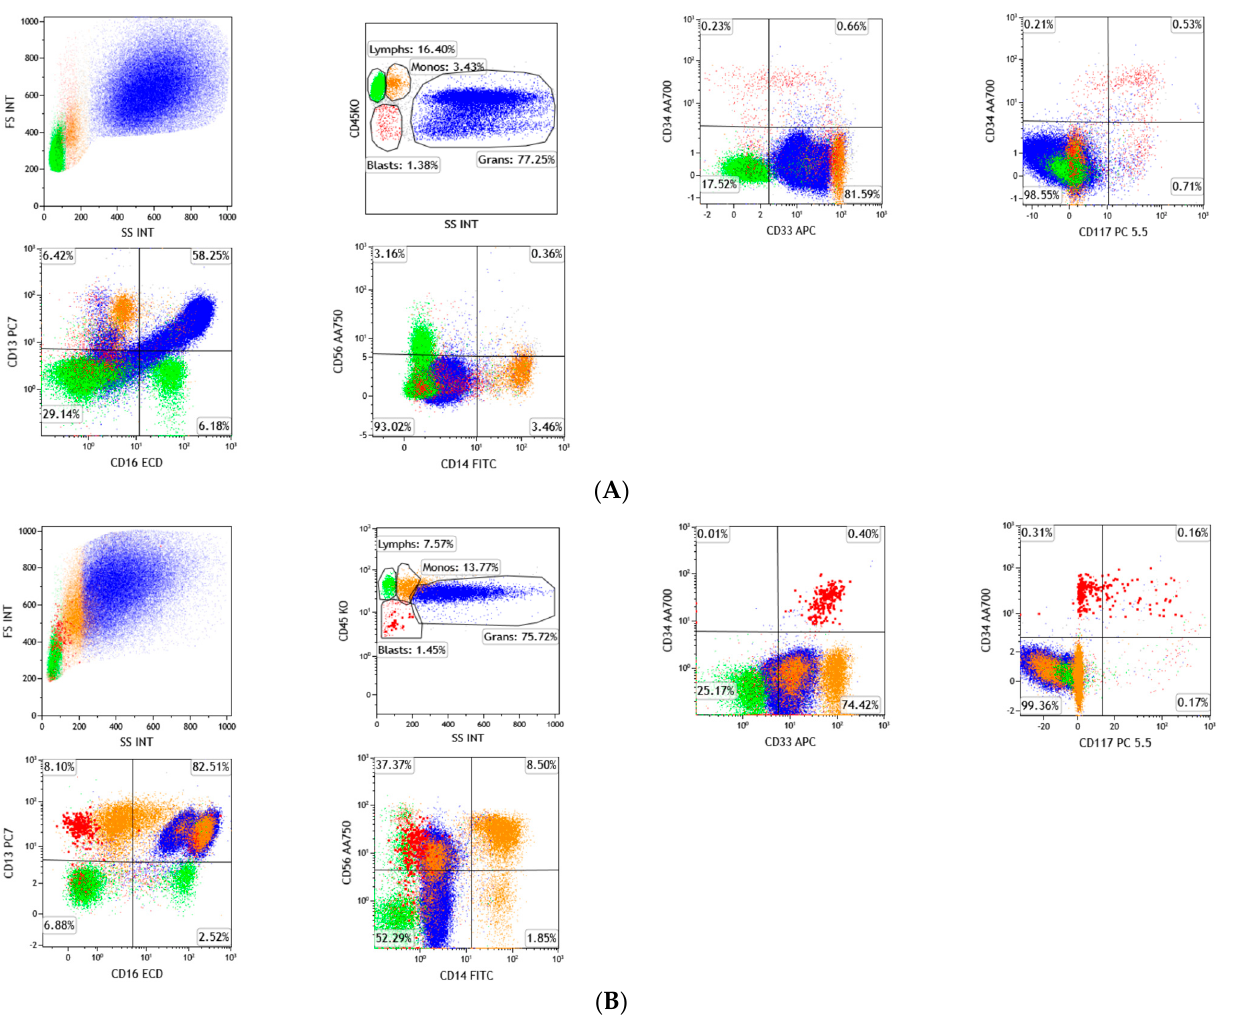
Figure 2. ( A ) Shows normal maturational pattern of nucleated hematopoietic cellular populations. Regenerating myeloblasts showing intact CD34 and CD117 expression and heterogeneous CD33 positivity. Maturing granulocytic precursors showing the classic “Nike swoosh” pattern in the CD13/CD16 plot, and monocytes showing intact expression of CD14, without aberrant antigen expression. Lymphocytes in green, monocytes in orange, granulocytes in blue, blasts in red ; ( B ) Case of MDS showing myeloblasts with loss of CD117 and with concurrently bright CD33 intensity. Prominent abnormal granulocytic maturational pattern in CD13/CD16 plot, losing the classic “Nike swoosh” pattern. In this MDS case, the granulocytes and monocytes also show aberrant CD56 expression; Lymphocytes in green, monocytes in orange, granulocytes in blue, blasts in red.